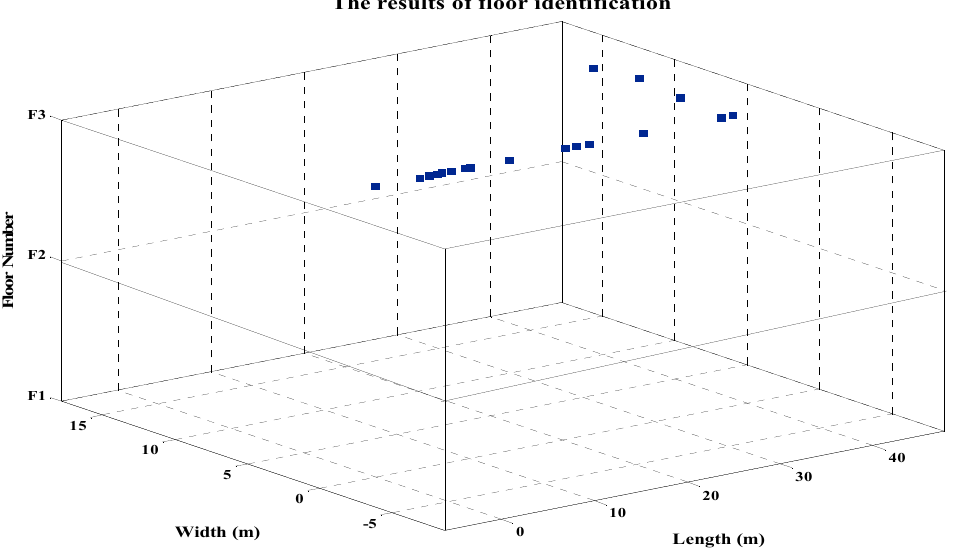
Figure 10. The results of floor identification.